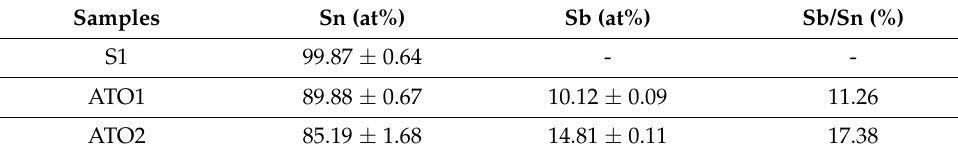
Table 2. Elemental composition of samples obtained from XRF analysis.